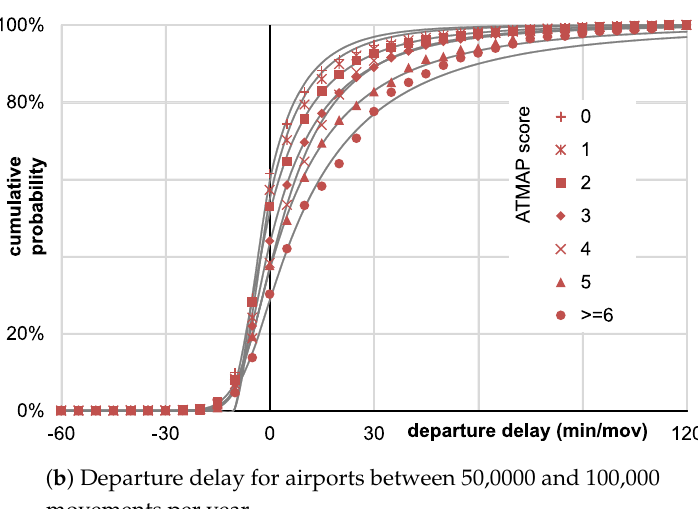
Figure 14. Distributions for ( a ) arrival and ( b ) departure delays at airports at different local weather conditions (cumulative density